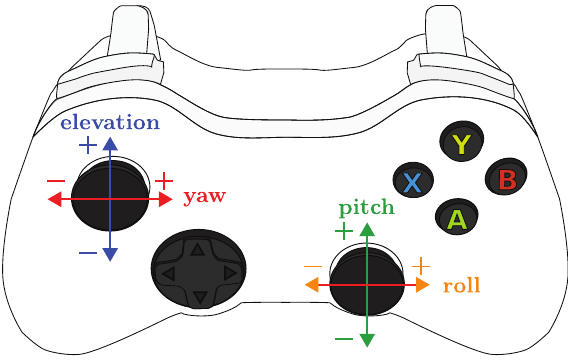
Figure 7. The teleoperation